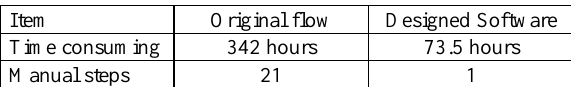
Table 2. Experiment